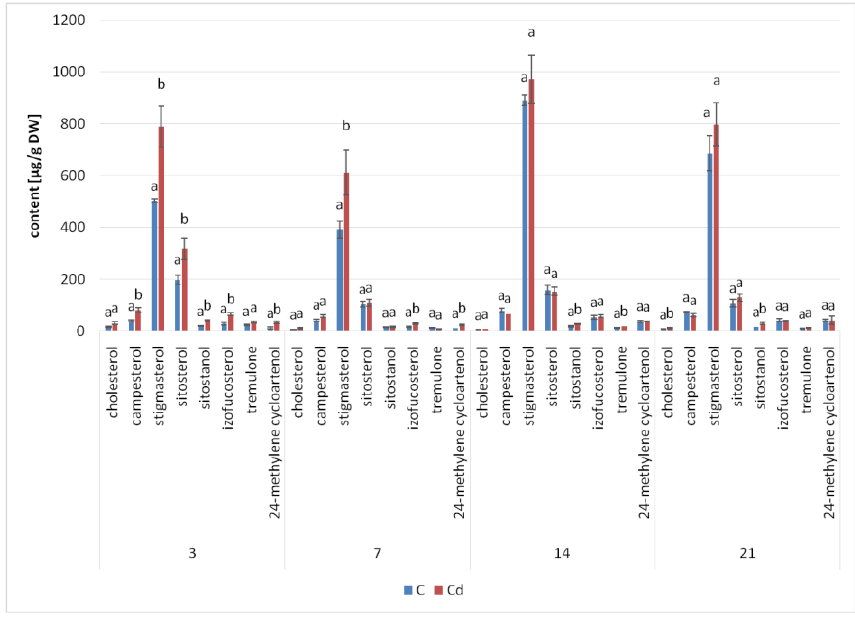
Figure 5. The effect of cadmium treatment on steroid content. Bars which do not share a common letter are significantly different ( p < 0.05).